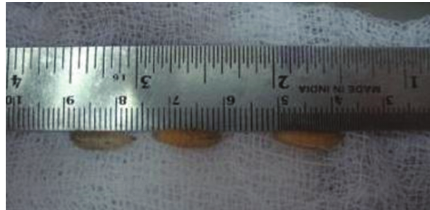
Figure 4: Picture showing live maggots harvested from the affected